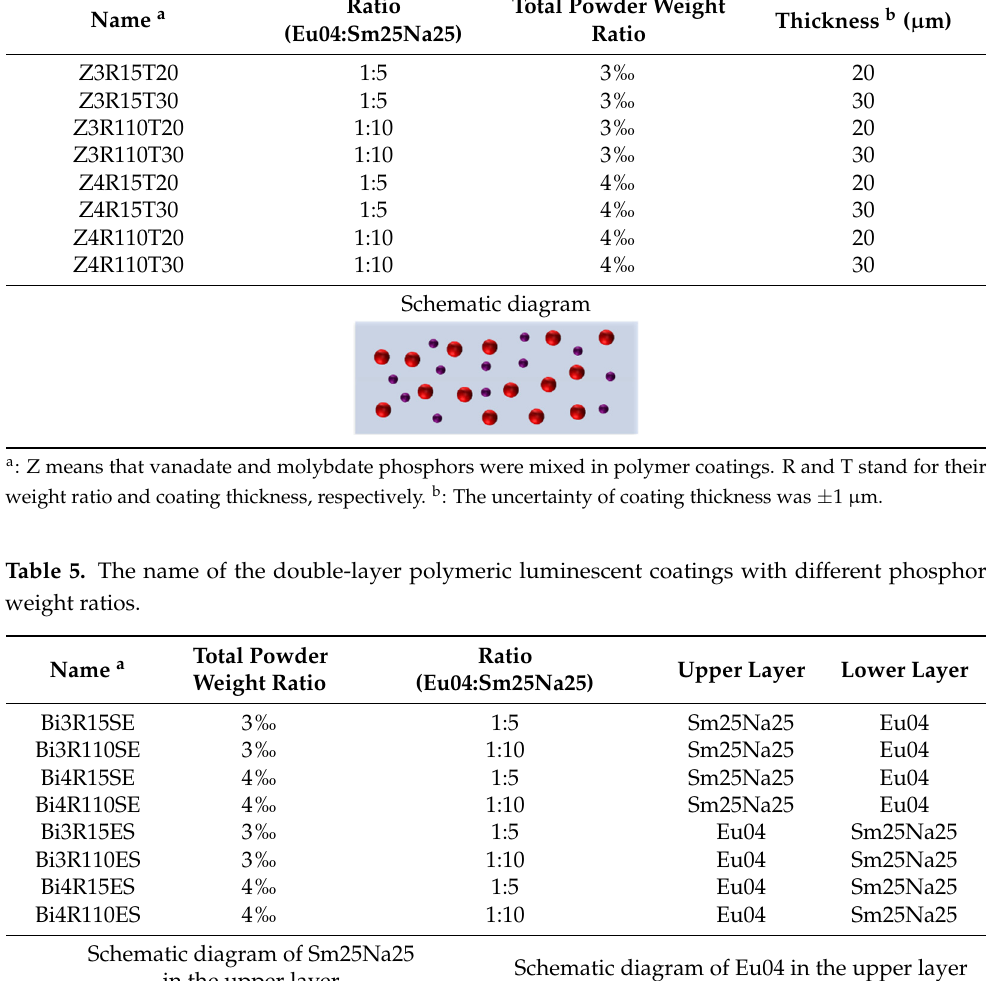
upper layer Schematic diagram of Sm25Na25 in the Schematic diagram of Eu04 in the upper